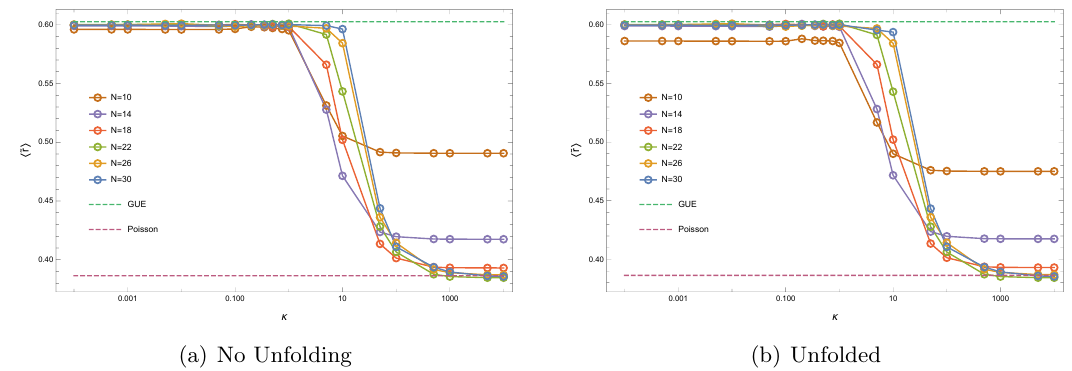
Figure 18 . The mean value of the ~ r -parameter for N = 10 ; 14 ; 18 ; 22 ; 26 ; 30 (cid:17) 2 ; 6 (mod8) of (a) the spectrum without unfolding (b) the unfolded spectrum. The average is performed over M = 5000 ; 3000 ; 1000 ; 300 ; 100 ; 100 ensembles, respectively. The transition from GUE to Poisson is observed.